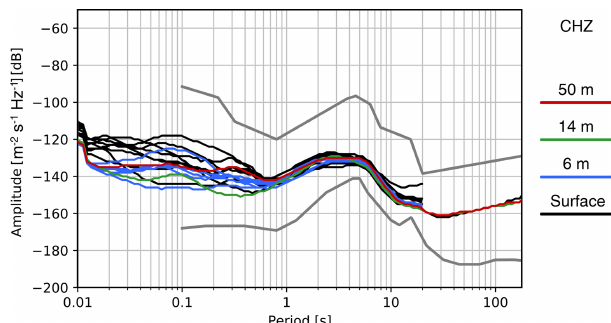
Figure 10. Median values of PPSD computed for the vertical com- ponents (channel CHZ) of sensors installed at different depths and locations over the entire period of operation of the INSIEME seis- mic network. Black curves are the median values of PPSD com- puted when sensors were installed on the surface; blue, green, and red curves refer to sensors installed at 6, 14, and 50m depth, respec- tively. For sensors with a flat response up to 20s, the median curves are plotted up to that period. The two grey curves indicate the new high- and low-noise